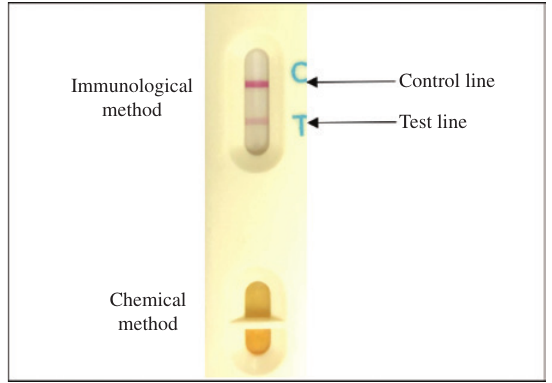
Figure 1: Immunological